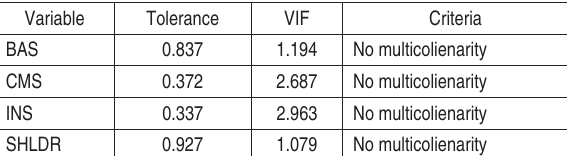
Table 2. Normality test result